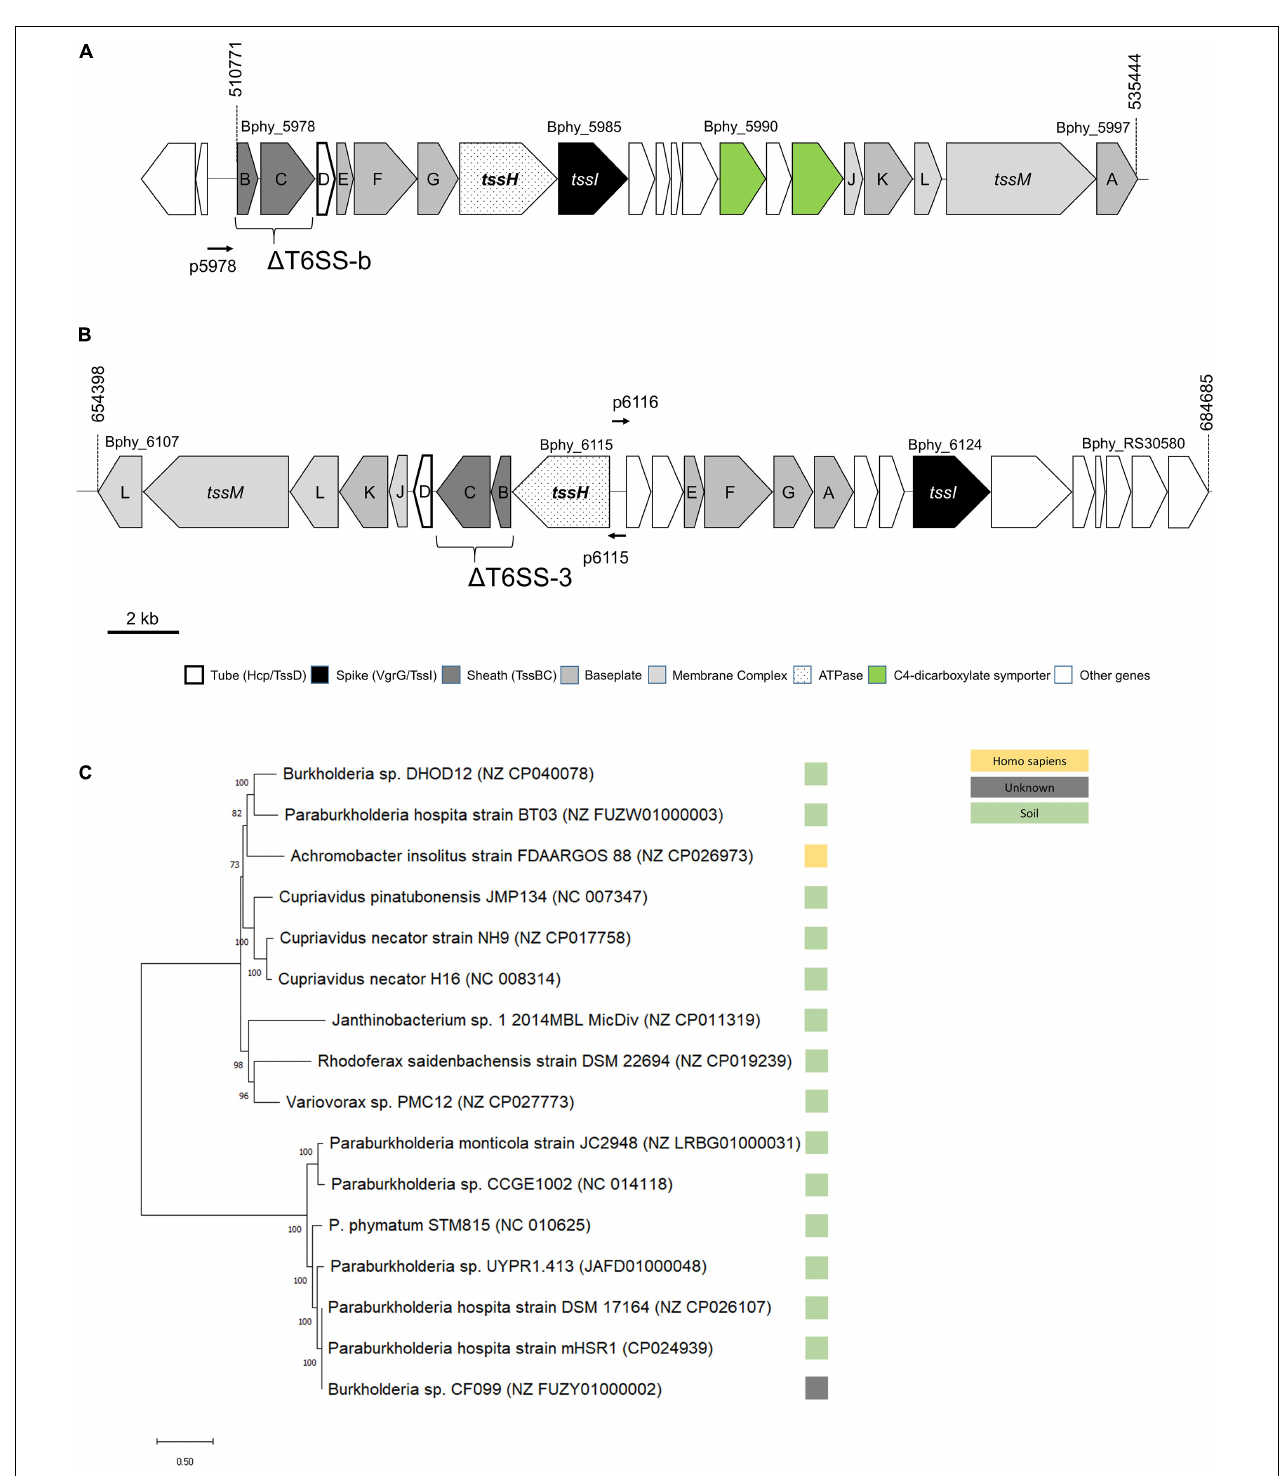
FIGURE 1 | Physical map of the two T6SS loci, (A) T6SS-b, (B) T6SS-3, and (C) unrooted maximum likelihood phylogenetic tree for T6SS-b. In (A,B) , numbers on top refer to nucleotide positions according to NCBI. The tssBC genes mutated to obtain the T6SS deletion ( (cid:49) ) mutants are shown. TheT6SS promoters cloned in vector pPROBE are also displayed with a horizontal thin arrow (p5978 with upstream region of Bphy_5978, p6115 with the promoter of Bphy_6115, and p6116 contains the promoter region of Bphy_6116). The phylogenetic tree of T6SS-b (C) is based on the DNA sequence as described in section “Materials and Methods”. The reference sequence accession numbers of the NCBI database is shown in brackets and the bootstrap values are shown left of the respective branches. The bar at the bottom left indicates the distance.